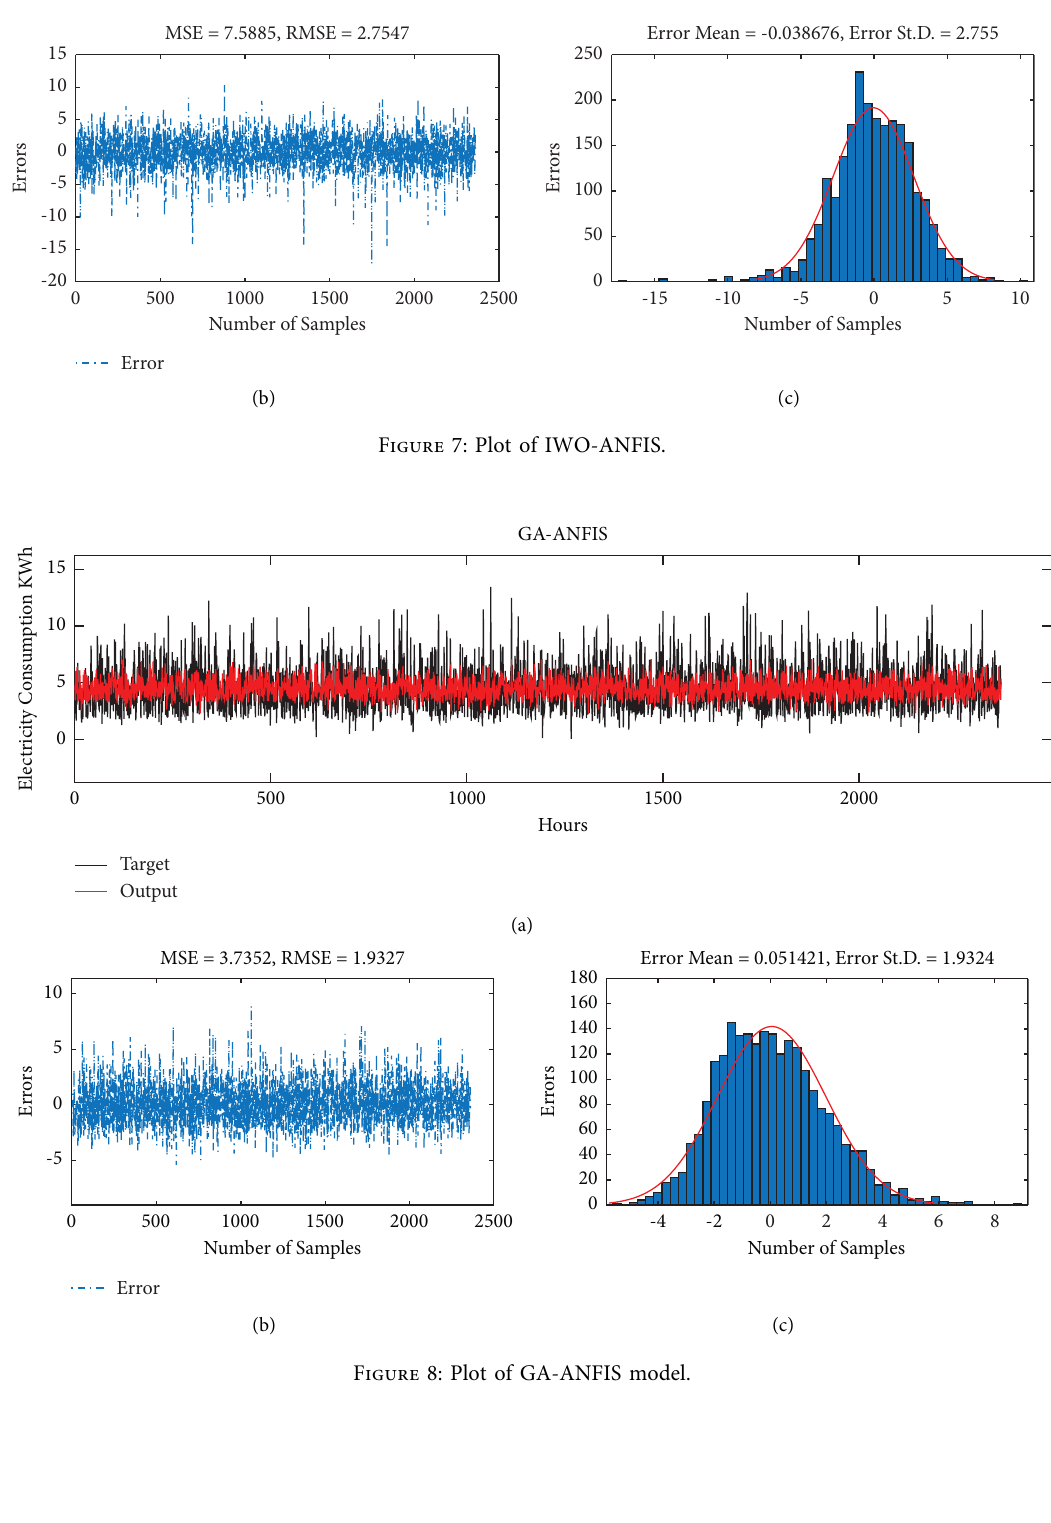
Figure 8: Plot of GA-ANFIS